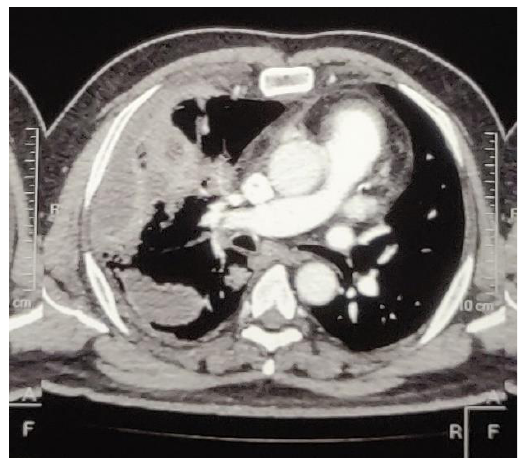
Figure 2 . CT thorax of the patient showing right lower lobe collapse with effusion